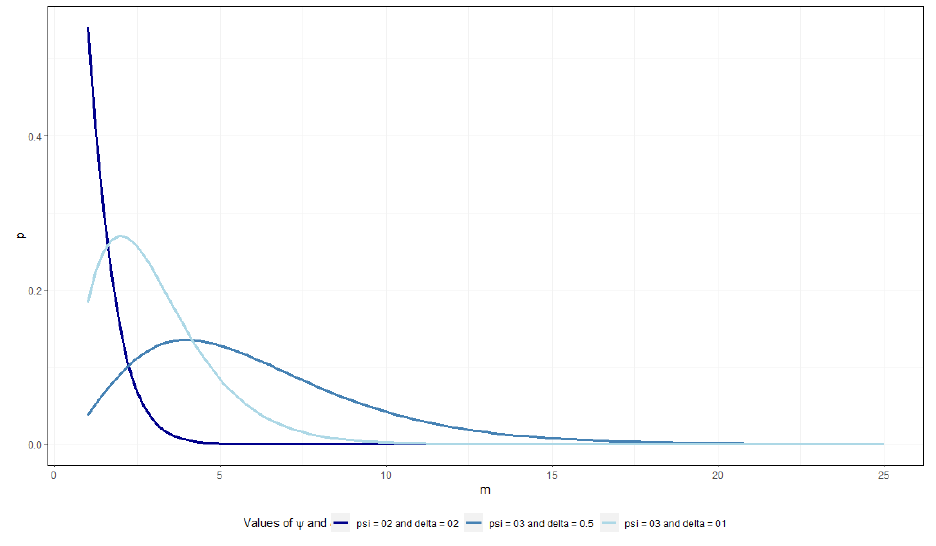
Figure A2. The negative binomial